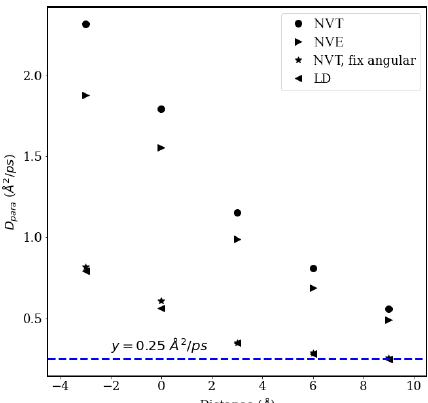
Figure A7. Diffusion coefficient D (cid:107) of water molecules (i.e., in the direction parallel to the interface) as a function of distance from the interface in simulations of a pure-water droplet with N w = 1000 carried out using different thermostats (calculated from the slope, from 2 to 6ps, of the MSD data shown in Fig.